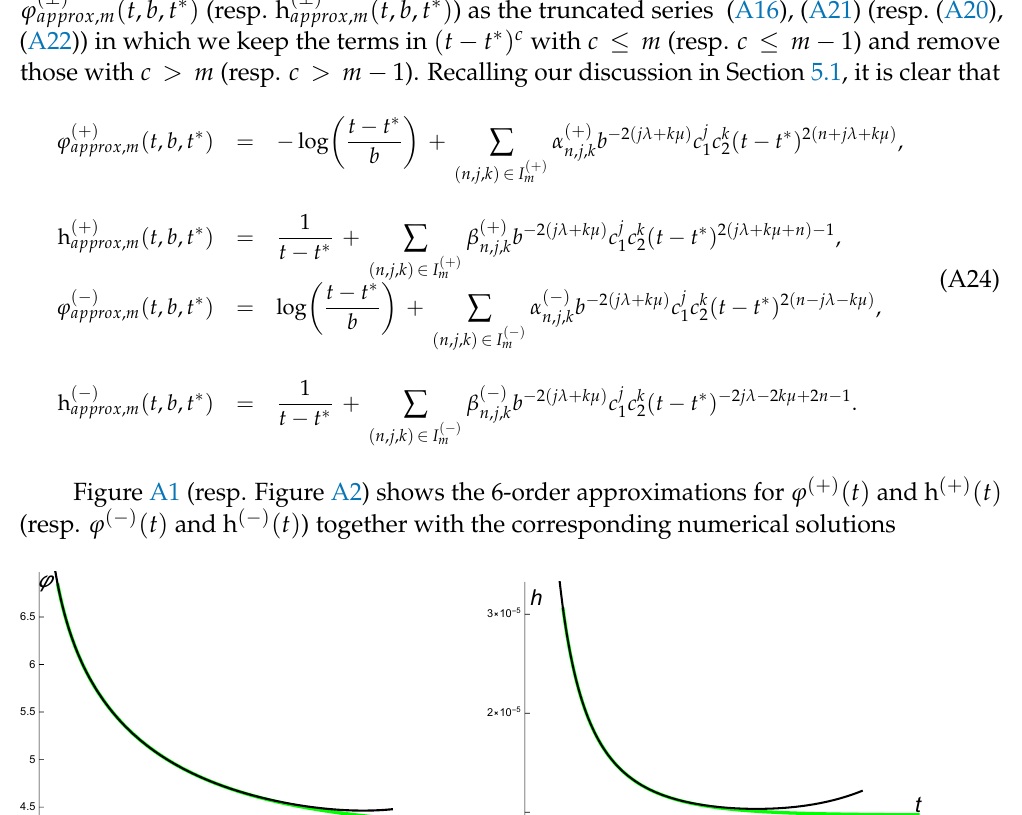
(+) ( t ) with b = 1.48 × 10 7 and ˙ ϕ = 0 , b 0 ,0 0 0 approx ,6 ( t , b ) 0 ,0 approx ,6 √ √ 3 2 , µ = , c 1 = 2 × 10 − 10 , 3 4